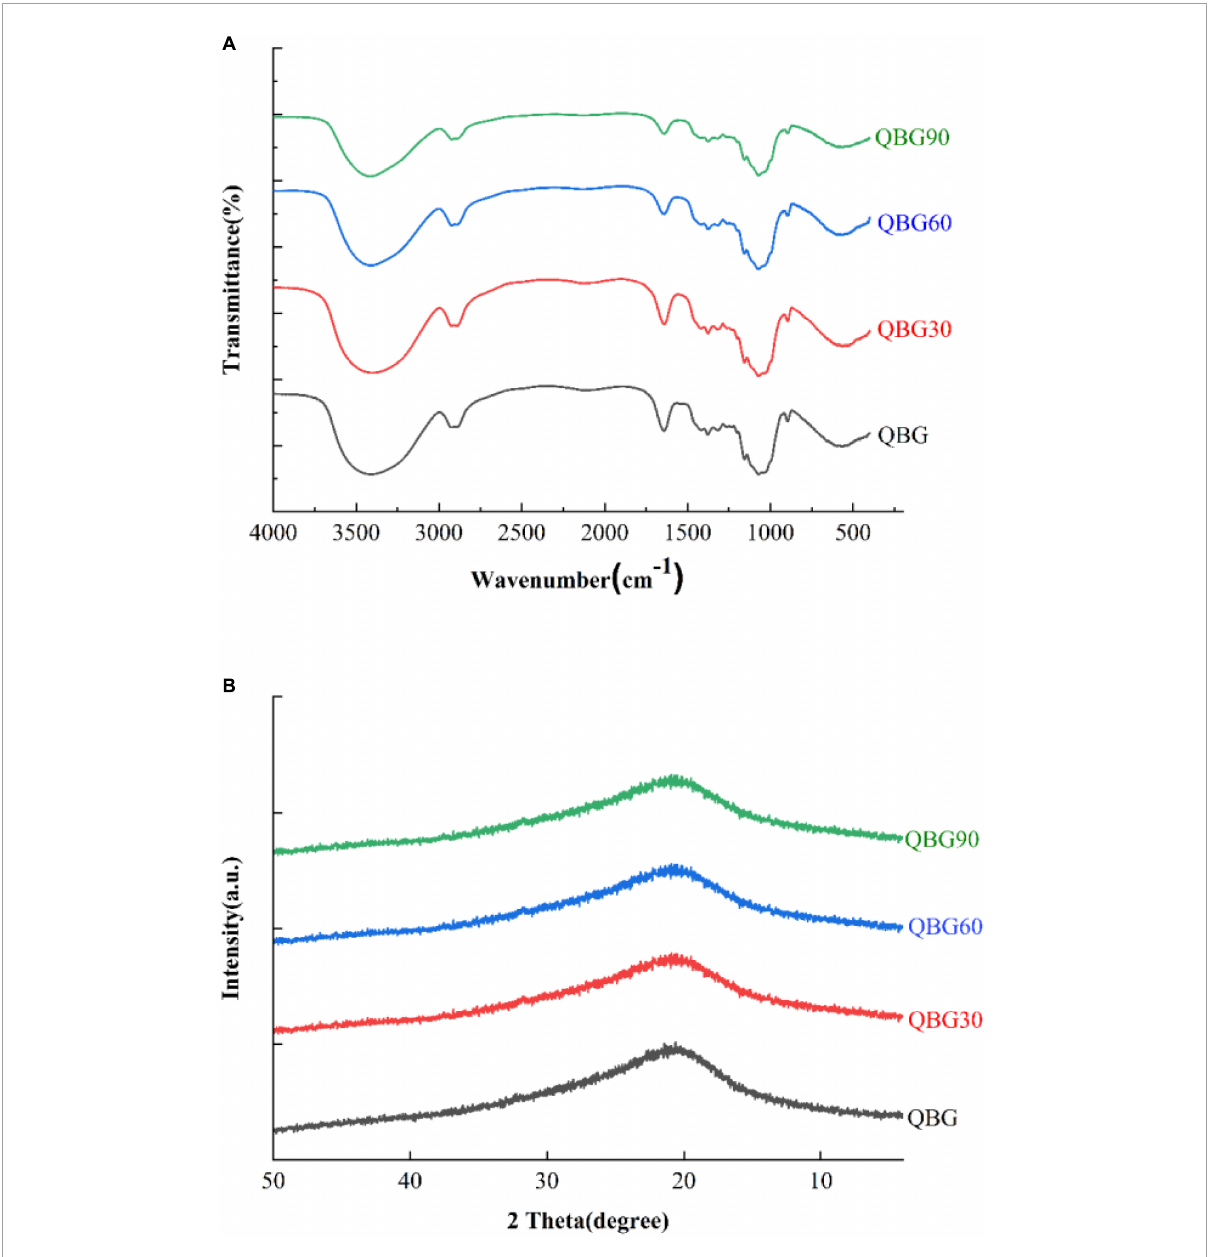
FIGURE2 The FTIR spectra (A) and XRD spectra (B) of Qingke β -glucan samples.